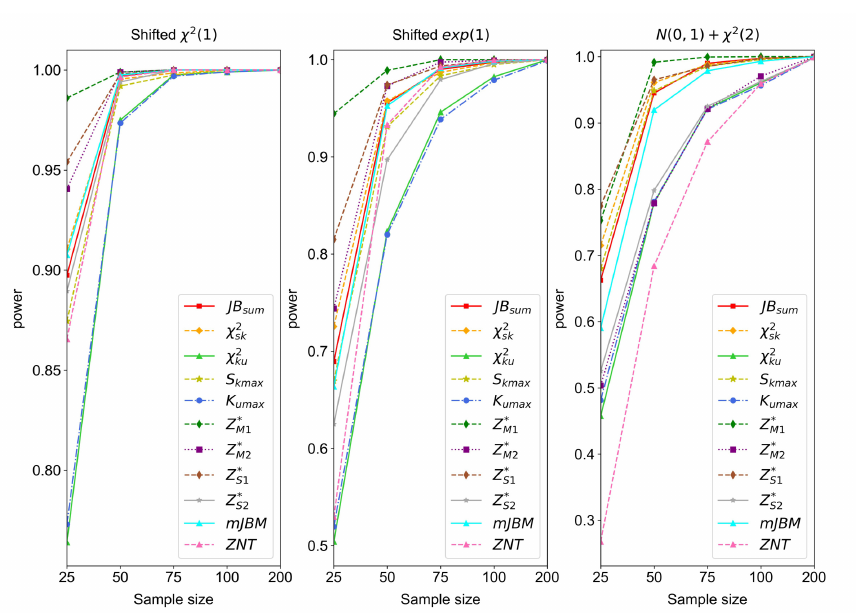
Figure 1. Empirical power of proposed PC-type JB testing compared with other methods ( p =